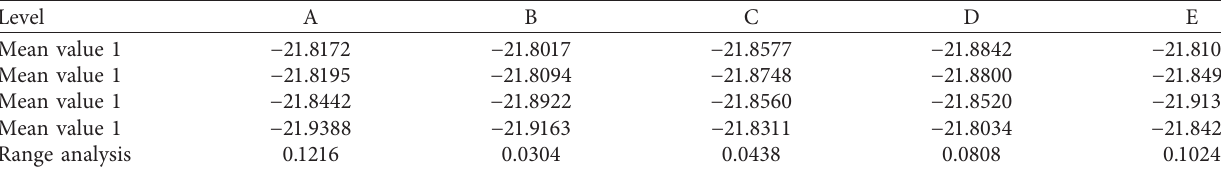
Table 12: SNR range